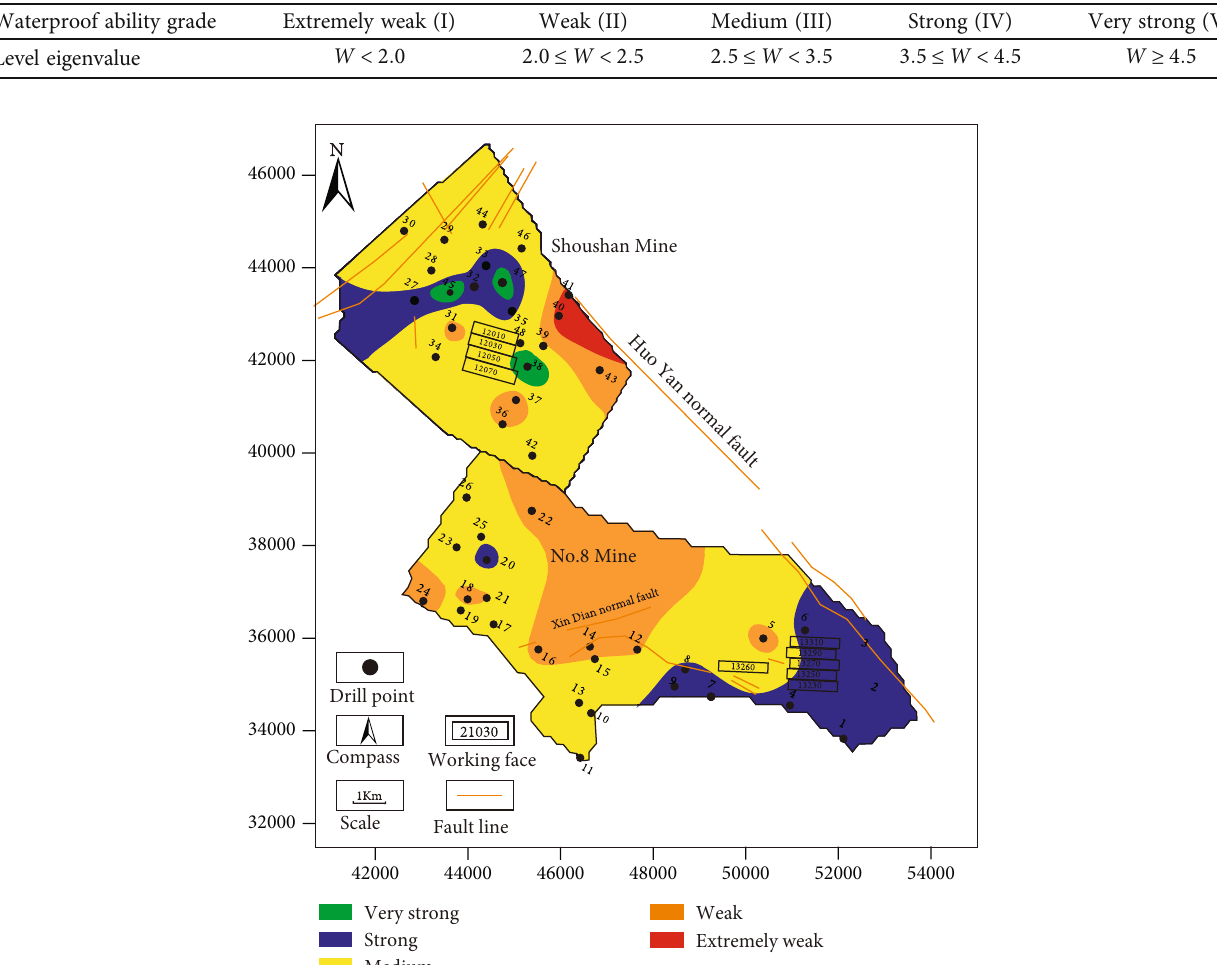
Table 12: Classi fi cation standards for water resistance.